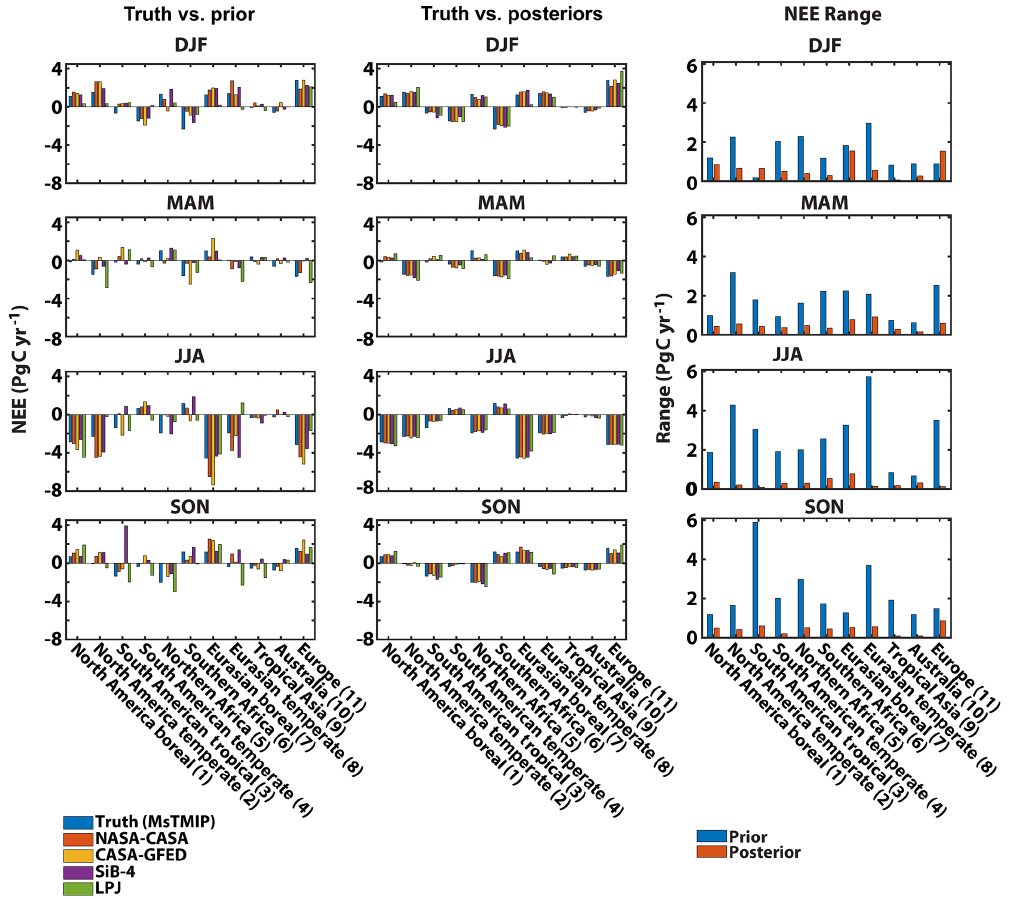
Figure 8. Seasonally averaged NEE averaged over the 11 TransCom-3 land regions from MsTMIP (truth) vs. the prior biosphere models (NASA-CASA, CASA-GFED, SiB-4, and LPJ) (left column), posterior estimates (middle column) from the OSSE simulations, and the corresponding range of prior and posterior NEE (right column). The synthetic observations in these OSSE simulations correspond to the OCO-2 OG observing mode. Detailed statistics of the truth, multi-model means of prior and posterior NEE estimates, standard deviations, and ranges displayed in this figure are listed in Table